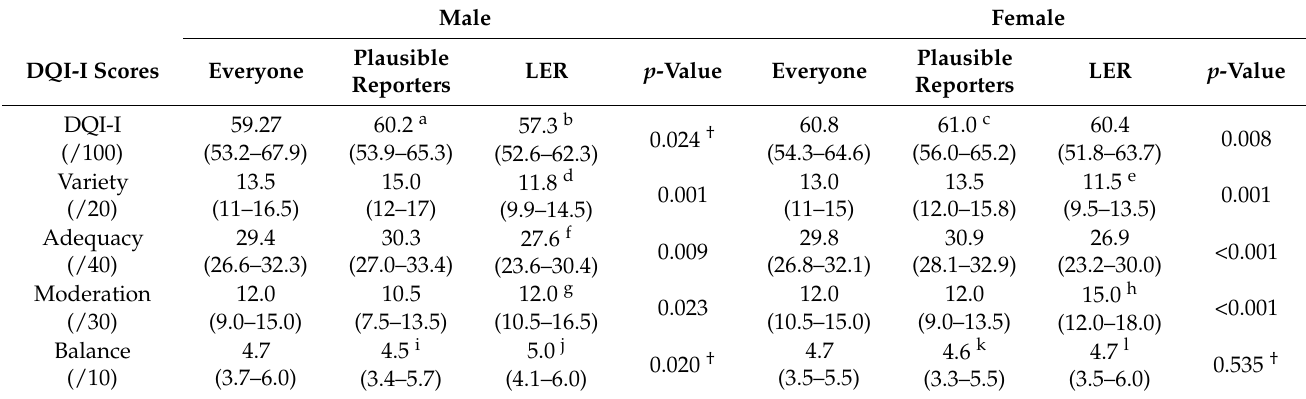
Table 3. Summary of DQI-I scores by sex between all reporters, plausible reporters and LER. Male